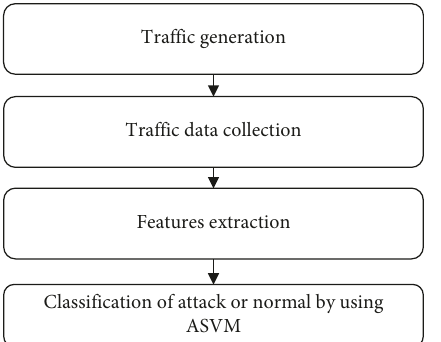
Figure 3: Four modules of our proposed system framework.